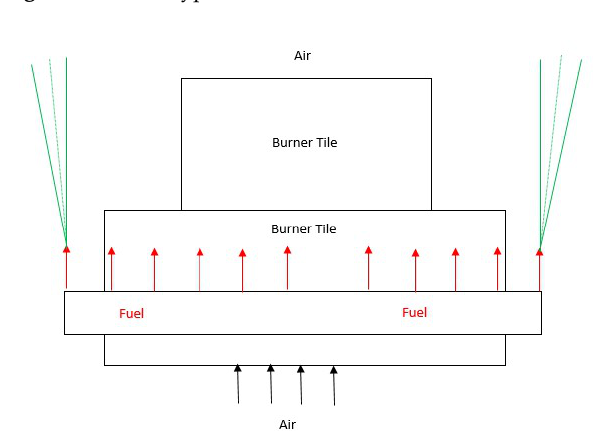
Figure 6. Burner type 2